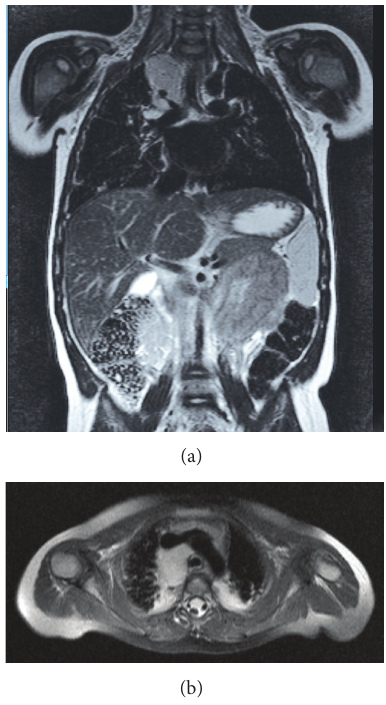
Figure 1: (a) Coronal T2 MRI: complex nodular posterior medi- astinal mass infiltrating the right hilum; (b) axial T2 MRI: bilateral mediastinal and hilar